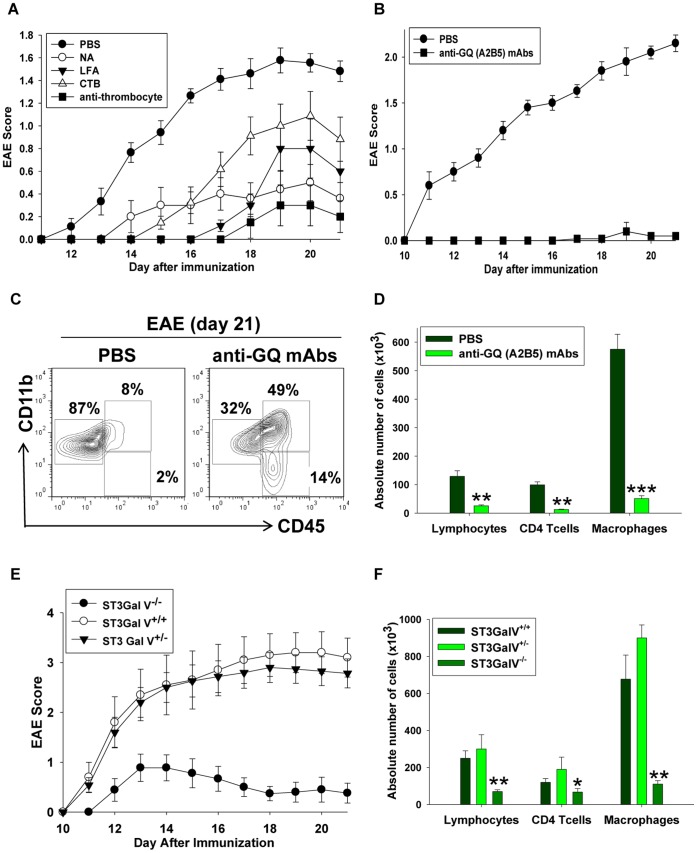
Effects of the agents that affect the platelet-lipid raft interactions in the development of EAE.(A,B) EAE in mice treated with anti-thrombocyte serum (anti-thromocyte), beta subunit of cholera toxin (CTB), neuroaminidase (NA), and Limax flavus agglutinin (LFA) (A) or anti-GQ (A2B5) antibodies (B). EAE was induced by the immunization of B6 with MOG/CFA as described in Methods. Pertussis toxin (PTx) was administered i.p. on day 0 and day 2 post-immunization. The anti-thrombocyte serum was injected on day 0, 2, 4 and 8 post-immunization, and CTB, NA and LFA were injected on days 0, 2, 4, 6 and 8 post-immunization (A). The anti-GQ antibodies were injected on days 0, 2, 4, 8, 10, 12 and 14 post-immunization (B). The mice were monitored daily and the EAE score was assessed as described in Methods. Mean ± S.E. of the total number of animals from the three separate experiments with groups of 7–10 mice in each experiment is shown. (C,D) The flow cytometry analysis of the CNS infiltrating cells isolated from the mice treated with anti-GQ antibodies. The mononuclear cells were isolated from the CNS of the mice treated with PBS or anti-GQ antibodies on day 21 after EAE induction, stained for CD11b and CD45 and analyzed by flow cytometry as described in Methods. The staining for CD11b (y-axis) and CD45 (x-axis) of the CNS mononuclear cells is shown. The percentages of populations of resting CD11b+CD45low microglia (left gates), CD11b+CD45hi macrophages (upper right gates) and CD11b−CD45hi lymphocytes (lower right gates) are shown in (C). The quantification of the absolute number of macrophages, lymphocytes and CD4 T cells in the CNS is shown in (D). The absolute numbers of CD11b−CD45hi lymphocytes, CD3+CD4+ T cells and CD11b+CD45hi macrophages were calculated by multiplying the total cell count obtained using a hemocytometer by the percentage of these cells determined by flow cytometry. Mean ± S.E. of the group of five animals is shown. (E,F) The EAE disease course (E) and the quantification of the CNS immune cell infiltrate (F) in the groups of ST3Gal-V−/−, ST3Gal-V+/− and ST3Gal-V+/+ mice. The EAE was induced and cellular infiltration was analyzed as in (A) and (D), respectively. The mean ± S.E. of the total number of animals from the three separate experiments with the groups of 7–10 mice in each experiment is shown.